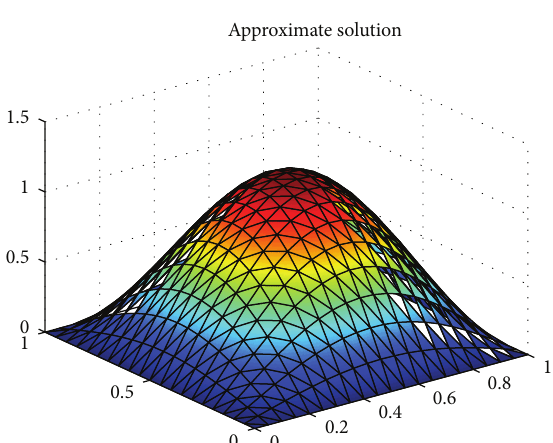
Figure 3: Approximate solution for NSFD-CG scheme.